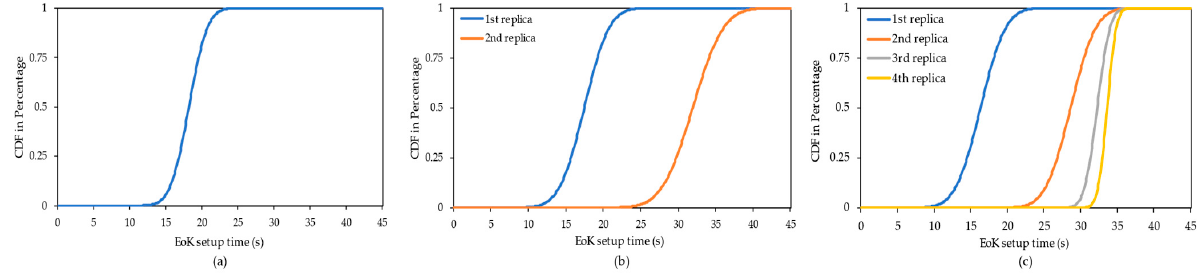
Figure 5. Total time for remote deployment and setup time for (a) 1 replica, (b) 2 replicas, and (c) 4 replicas.